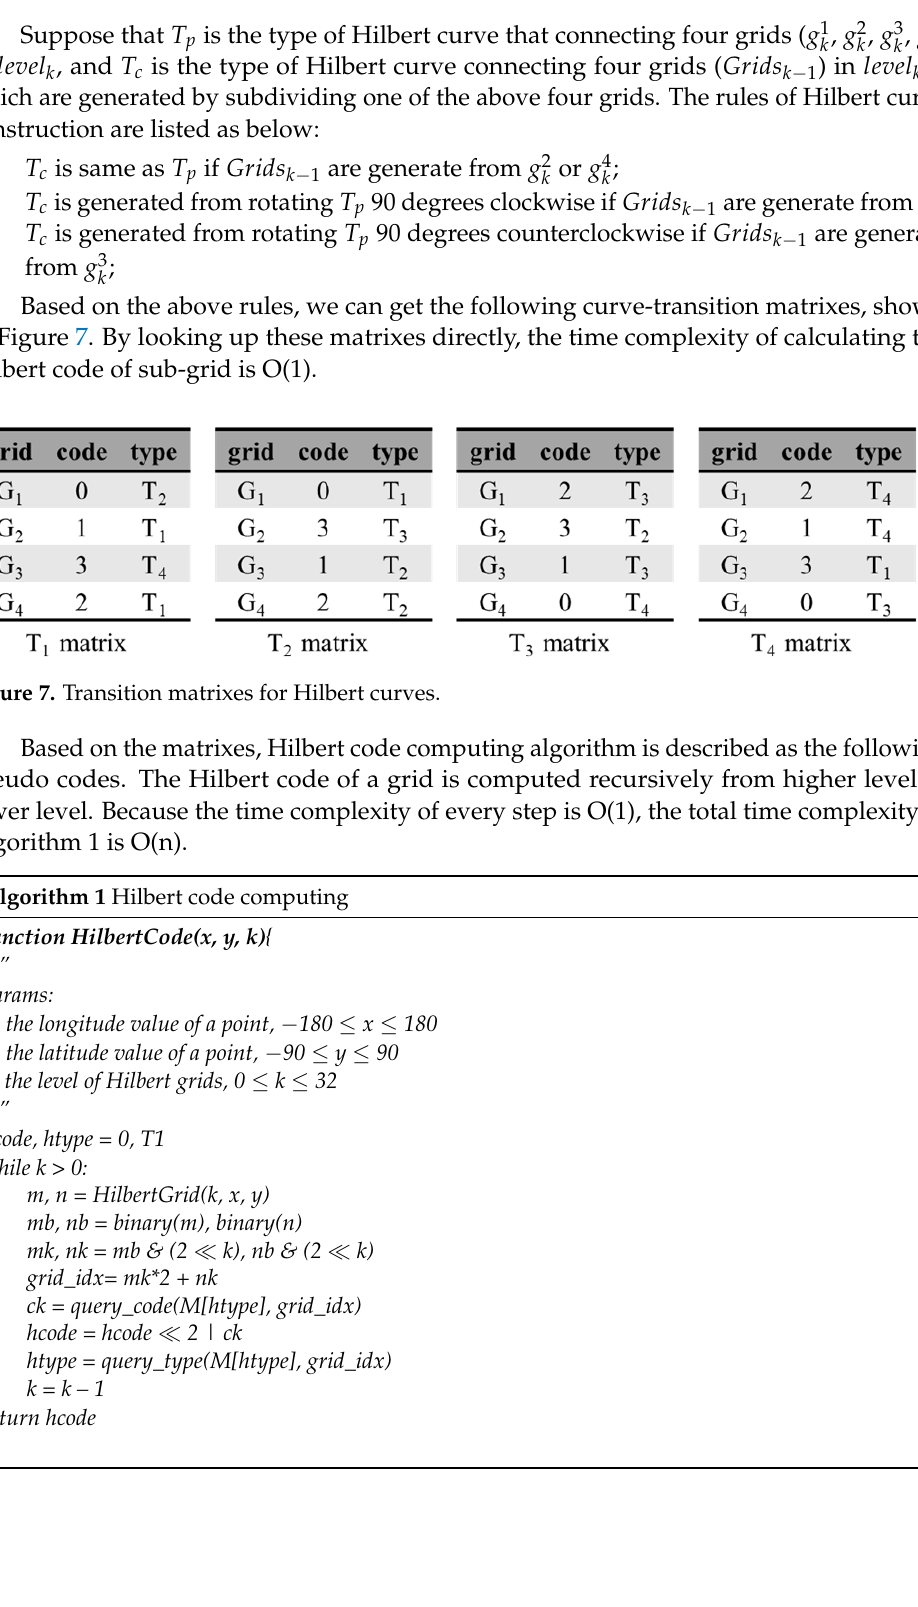
Figure 6. Basic shapes of Hilbert curve.